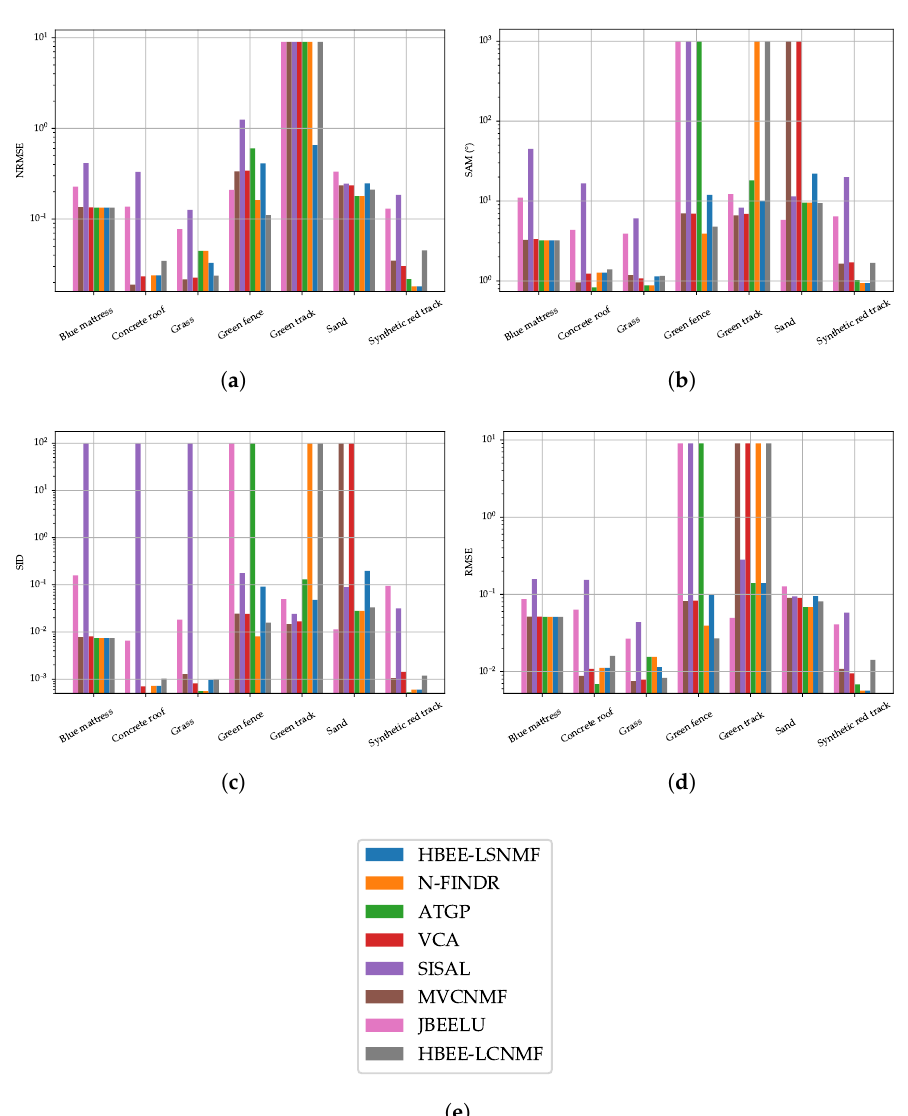
Figure 15. NRMSE ( a ), SAM ( b ), SID ( c ), and RMSE ( d ) performances for each estimated endmember for the Basel data set. Non-estimated endmembers are shown with values set to 9 for NRMSE, 9 for RMSE, 999 for SAM, and 99 for SID. Invisible bars mean the criterion values are very low. Legend is given in ( e